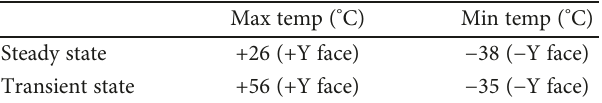
Table 6: Maximum/minimum